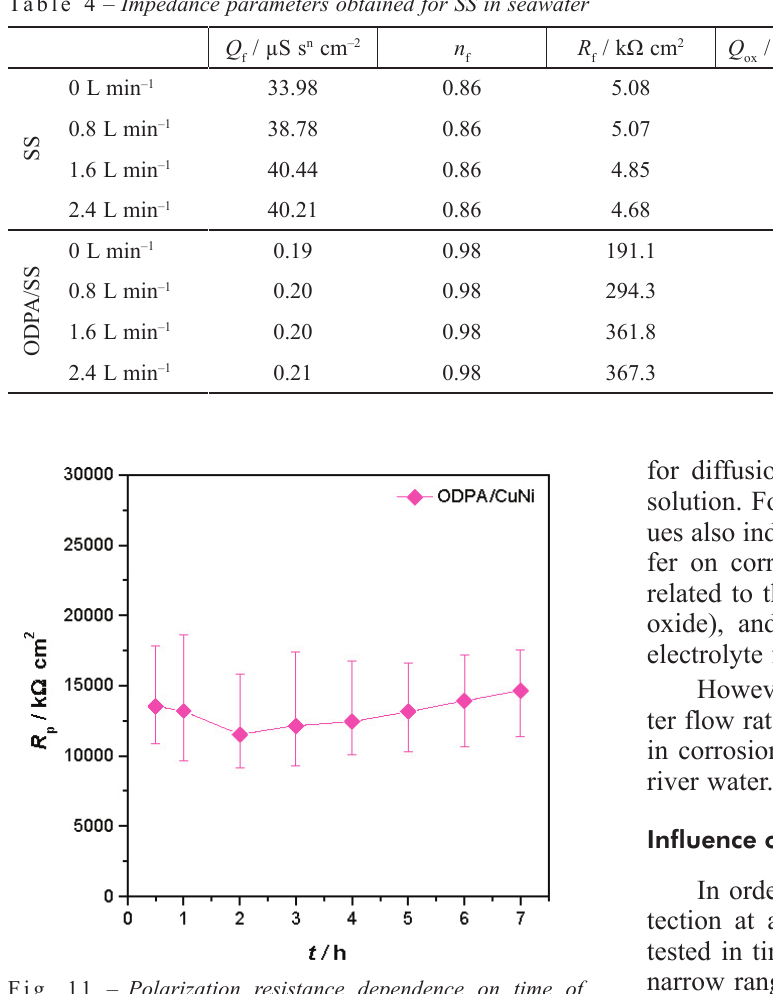
Fig. 11 – Polarization resistance dependence on time of exposure to river water measured at a flow of 2.4 L min